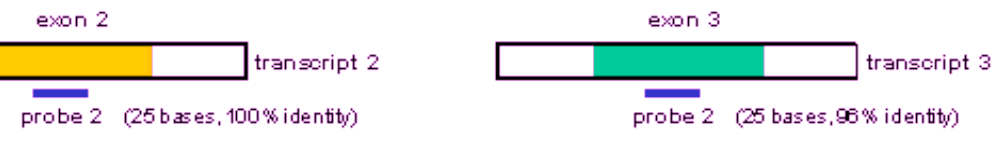
Figure 2: An example of a probe which is not considered to be mapping uniquely to an exon. Probe 2 aligns to one exon with 25 bases (100% identity) but also partially (25 bases and 96% identity) to another exon with an alignment value of 24 (25*0.96).